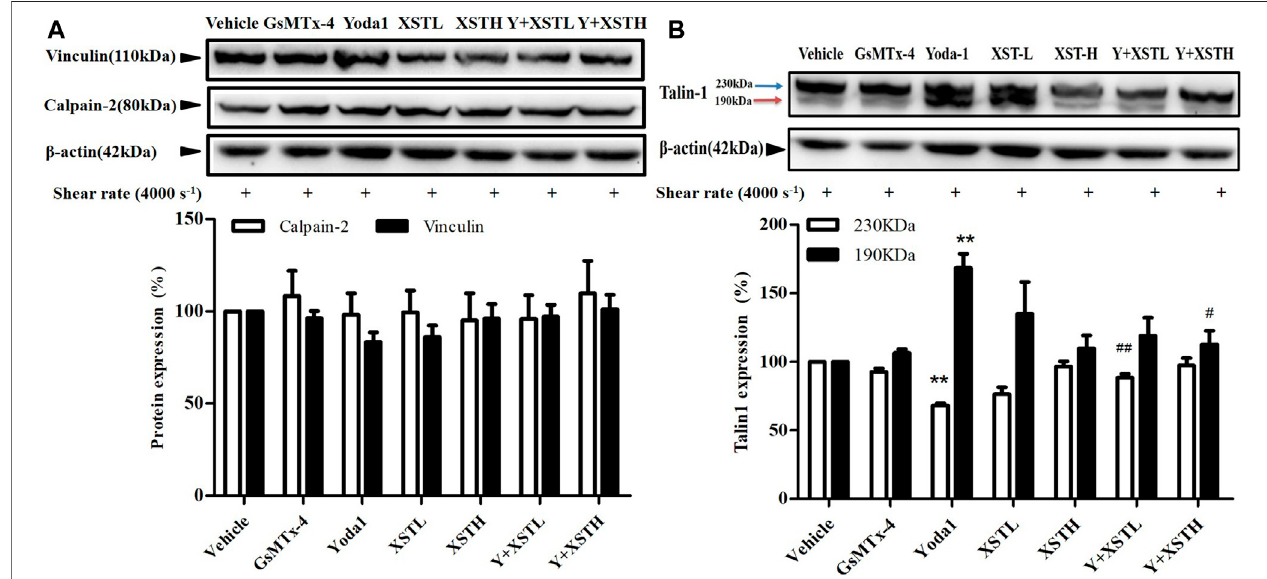
FIGURE6| EffectsofXSTontheexpressionofplateletaggregation-relatedproteinsundershearstress. (A) Westernblottinganalysisoftheexpressionofcalpain-2 and vinculin in platelets subjected to shear at a rate of 4,000 s − 1 and treated with saline, GsMTx-4 (2.5 µM), Yoda1 (25 µM) and XST at 0.15 g L − 1 (XSTL) or 0.6 g L − 1 (XSTH). Treatment with XST resulted in no signi fi cant alteration in the expression of calpain-2 and vinculin. (B) Western blotting analysis of talin1 cleavage in platelets subjected to shear at a rate of 4,000 s − 1 and treated with saline, GsMTx-4 (2.5 µM), Yoda1 (25 µM), and Yoda1 together with XST at 0.15 g L − 1 or 0.6 g L − 1 highlighted by black lines. Top: representative blots; bottom: mean data from three independent experiments. * p < 0.05, ** p < 0.01 compared to platelets subjected to shear alone; # p < 0.05, ## p < 0.01 compared to platelets treated with Yoda1 alone highlighted by black lines.